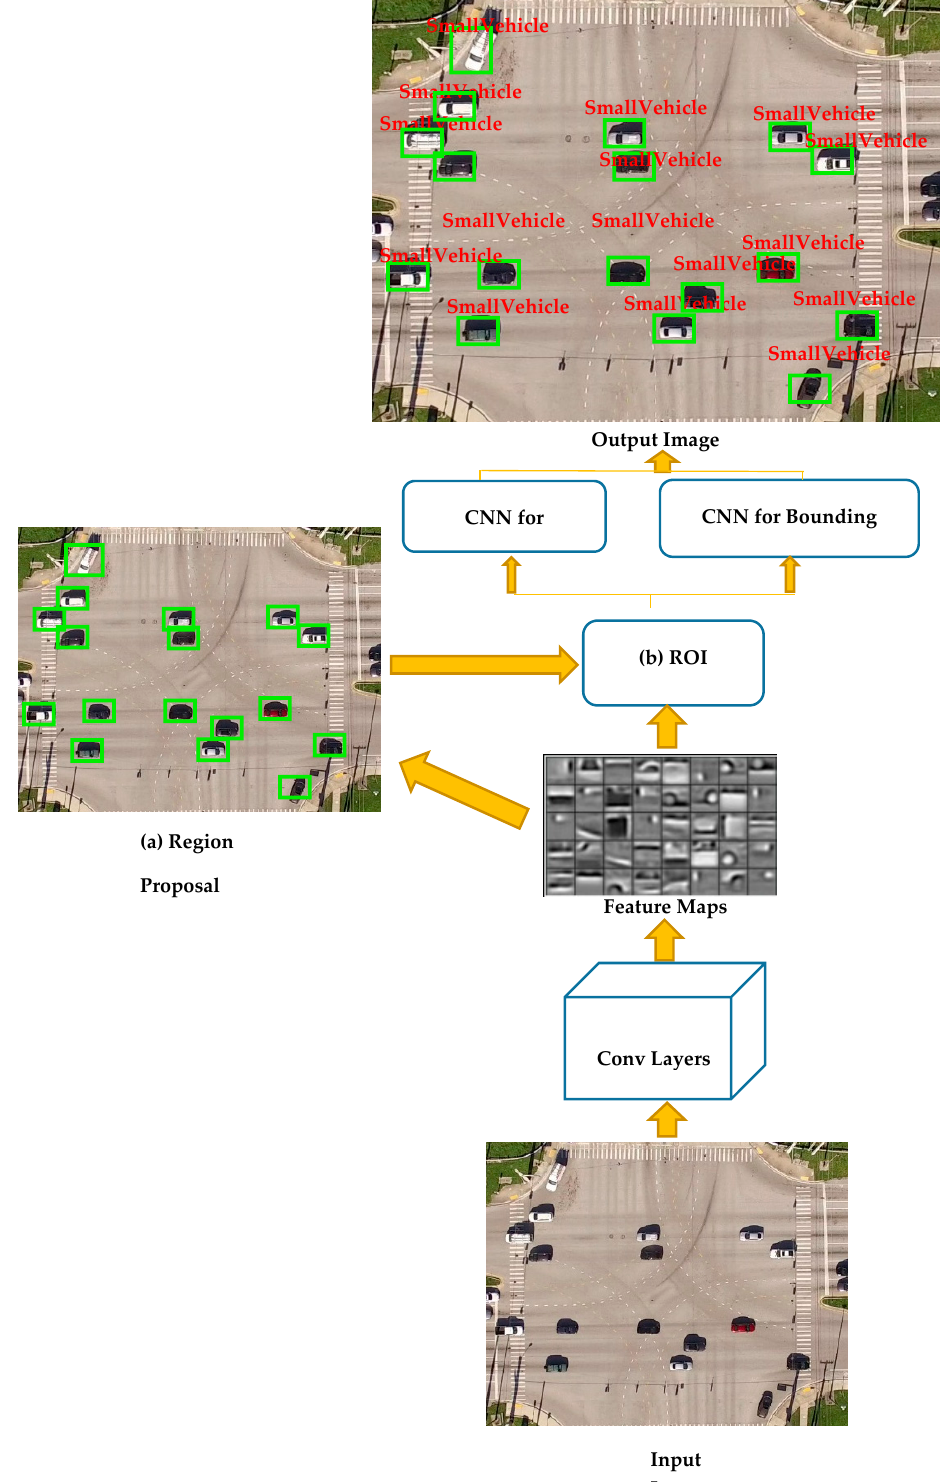
Figure 1. Faster region-based convolutional neural network (R-CNN) architecture.